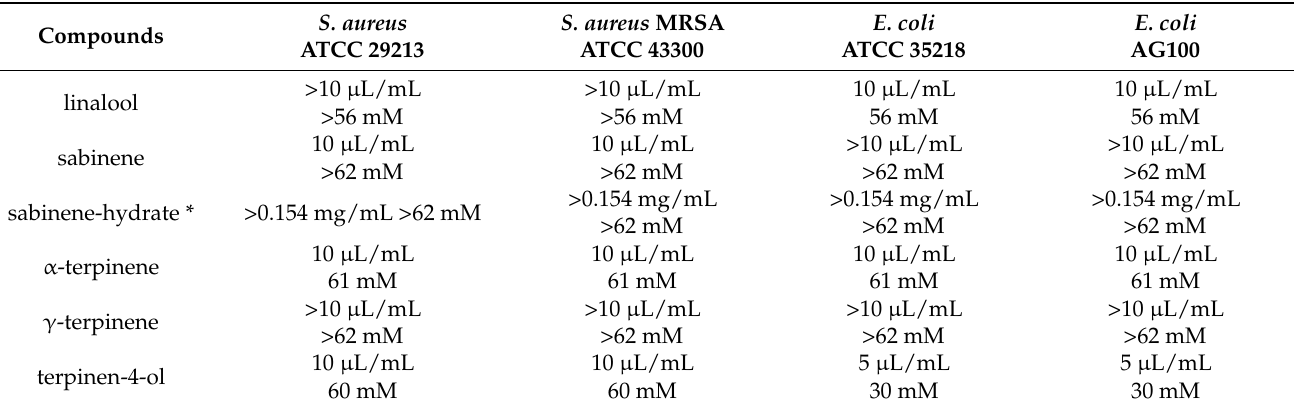
Table 4. Minimum inhibitory concentrations (MICs) of O. majorana essential oil